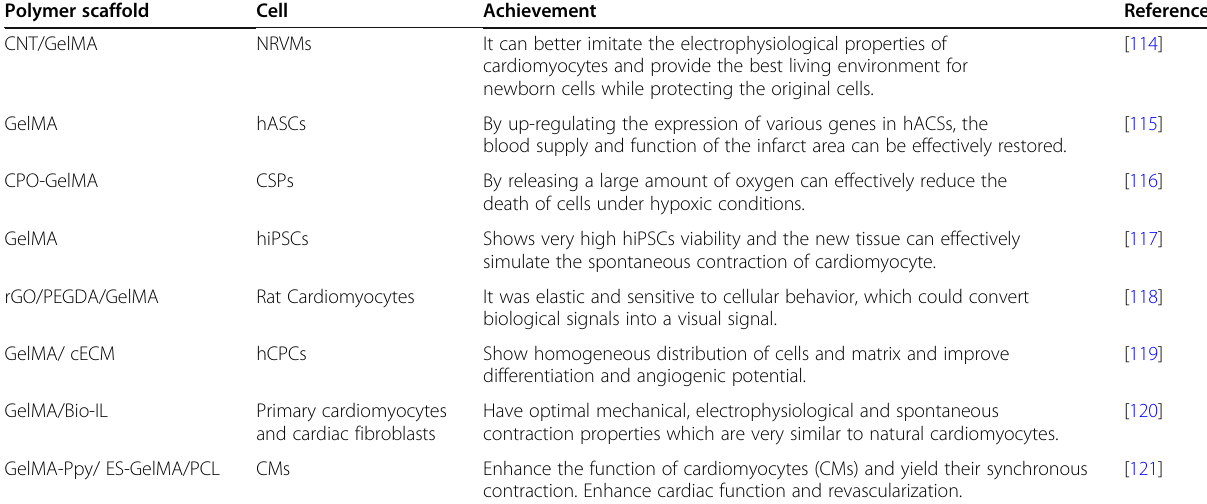
Table 6 The recent application of GelMA in heart engineering Polymer scaffold Cell Achievement